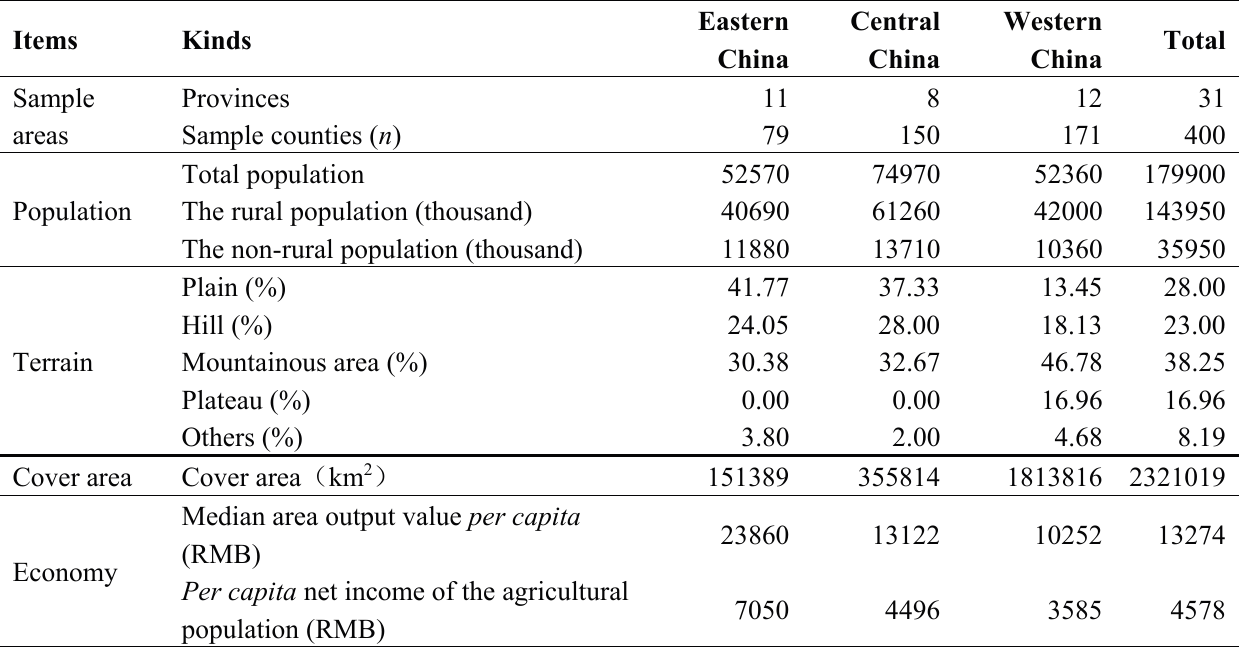
Table 2. Characteristics of the 400 sample counties in Eastern, Central and Western China in 2010.